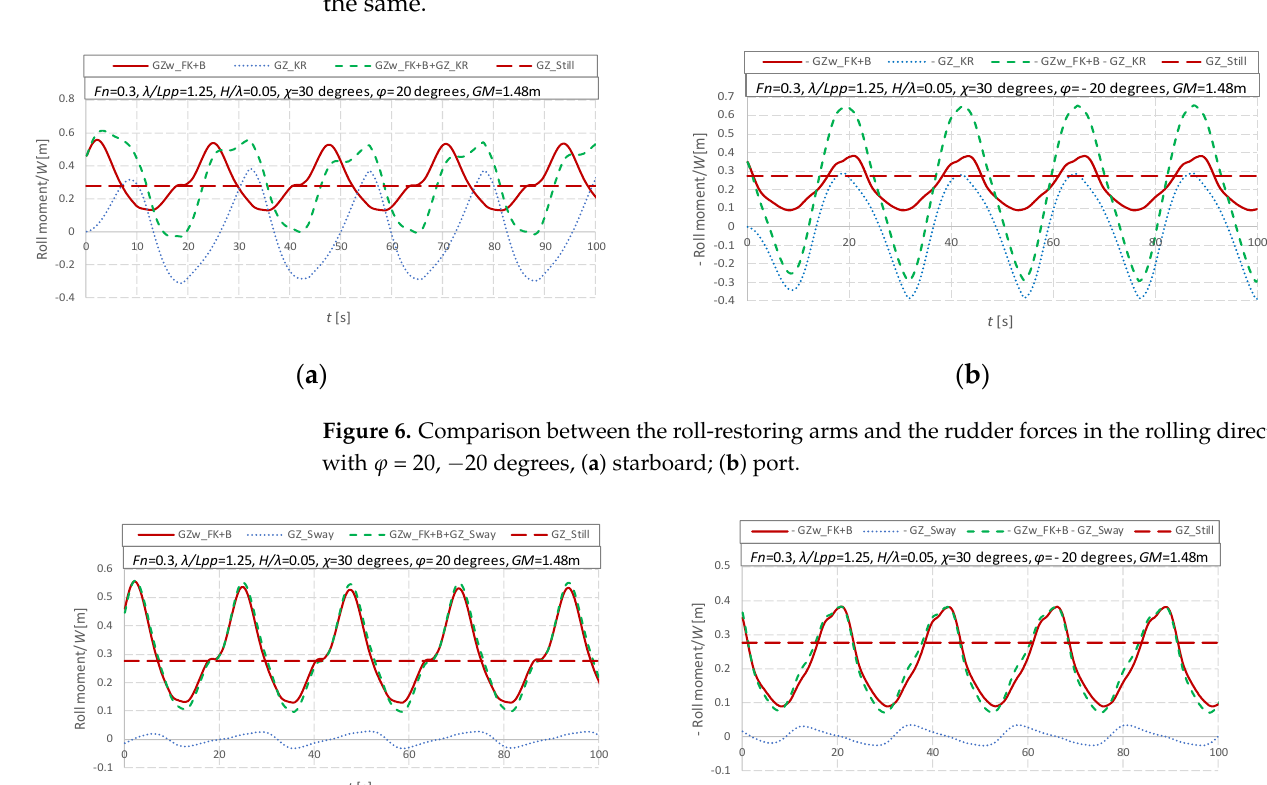
Figure 7. Comparison between the roll-restoring arms and the coupled sway forces in the rolling